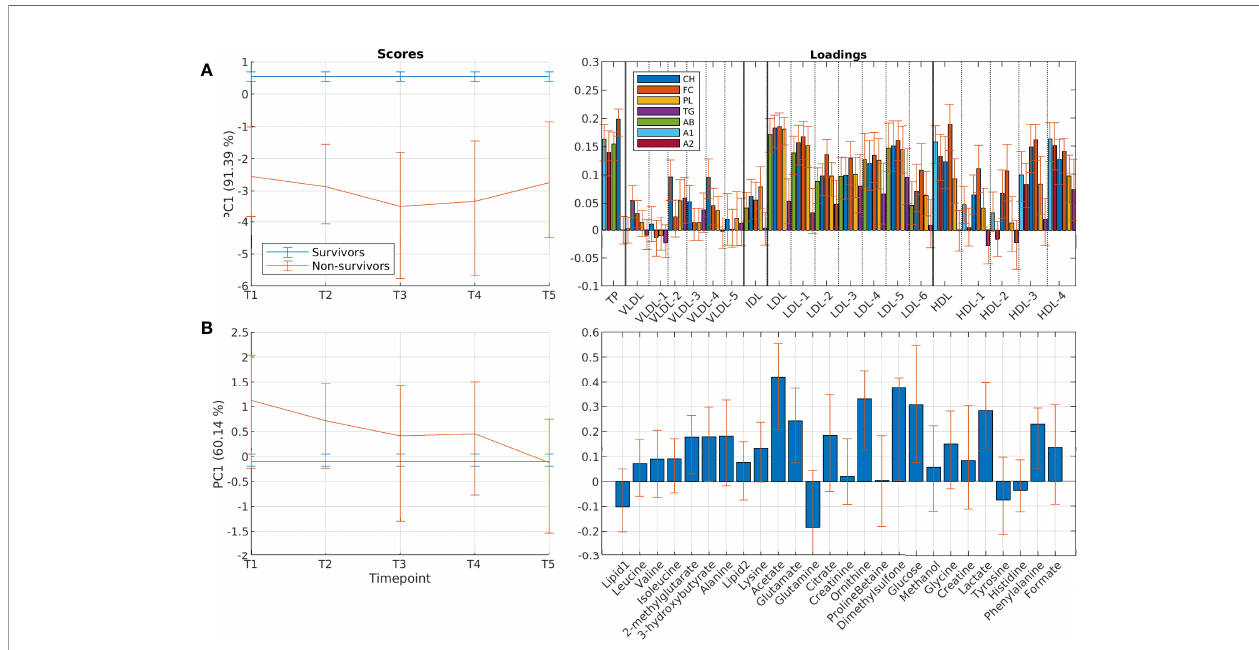
FIGURE 5 | Differences in circulating lipoprotein subfractions and metabolites between 10-year overall survivors and non-survivors. Results show scores and loadings from RM-ASCA+ analysis including group differences and time-group interactions for (A) lipoprotein subfractions and (B) circulating metabolites. Group variable is reference coded to overall survivors, which therefore is shown as a fl at line in the score plot. The scores (left) show the overall development for survival groups over time (T1-T5), and must be interpreted together with the corresponding loadings (right). Distinct differences in the lipoprotein pro fi les of non-survivors are apparent already at baseline. For instance, survivors have higher score value at all time points for the lipoprotein analysis, which means that the survivors have higher levels of variables with positive loadings and lower levels of variables with negative loadings. A1, apolipoprotein-A1; A2, apolipoprotein-A2; AB, apolipoprotein-B; CH, esteri fi ed cholesterol; FC, free cholesterol; PC, principal component; PL, phospholipids; TG,